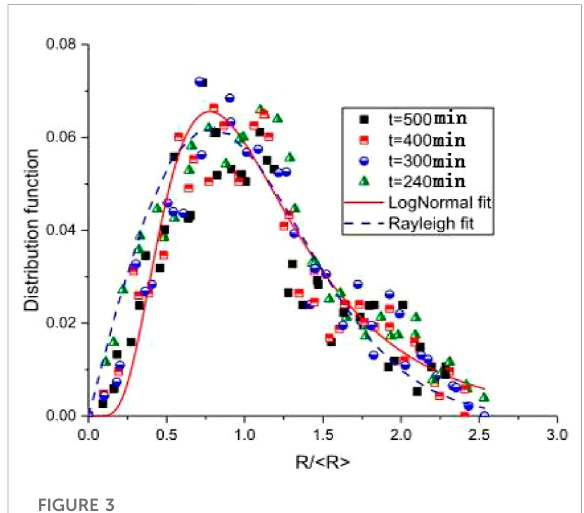
FIGURE 3 Grain size distribution function at N = 512 and L = 5.478